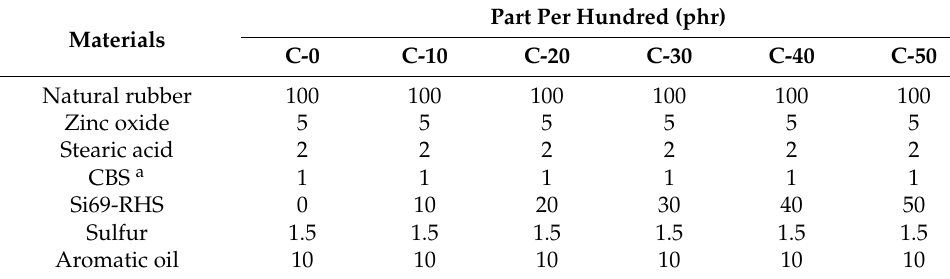
Table 1. Formulations of the NR compounds filled with Si69-RHS.